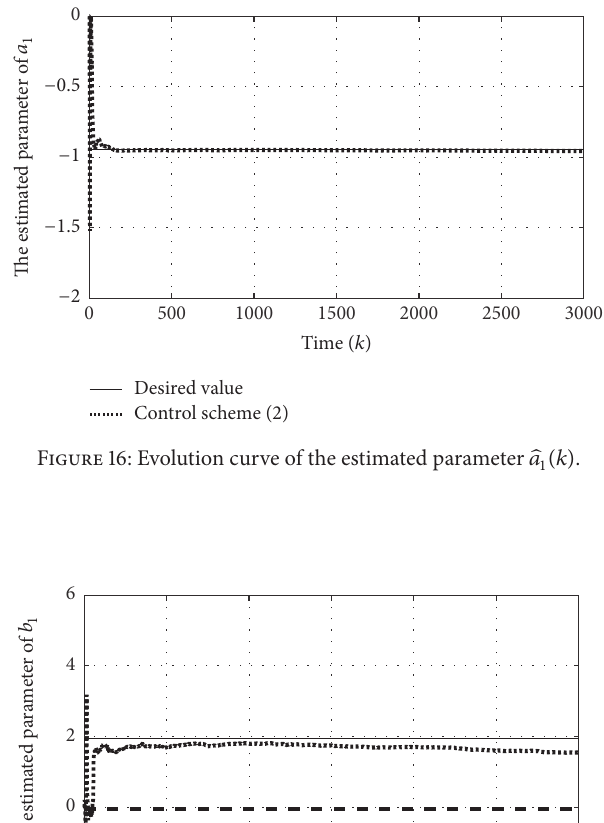
Figure 17: Evolution curve of the estimated parameter